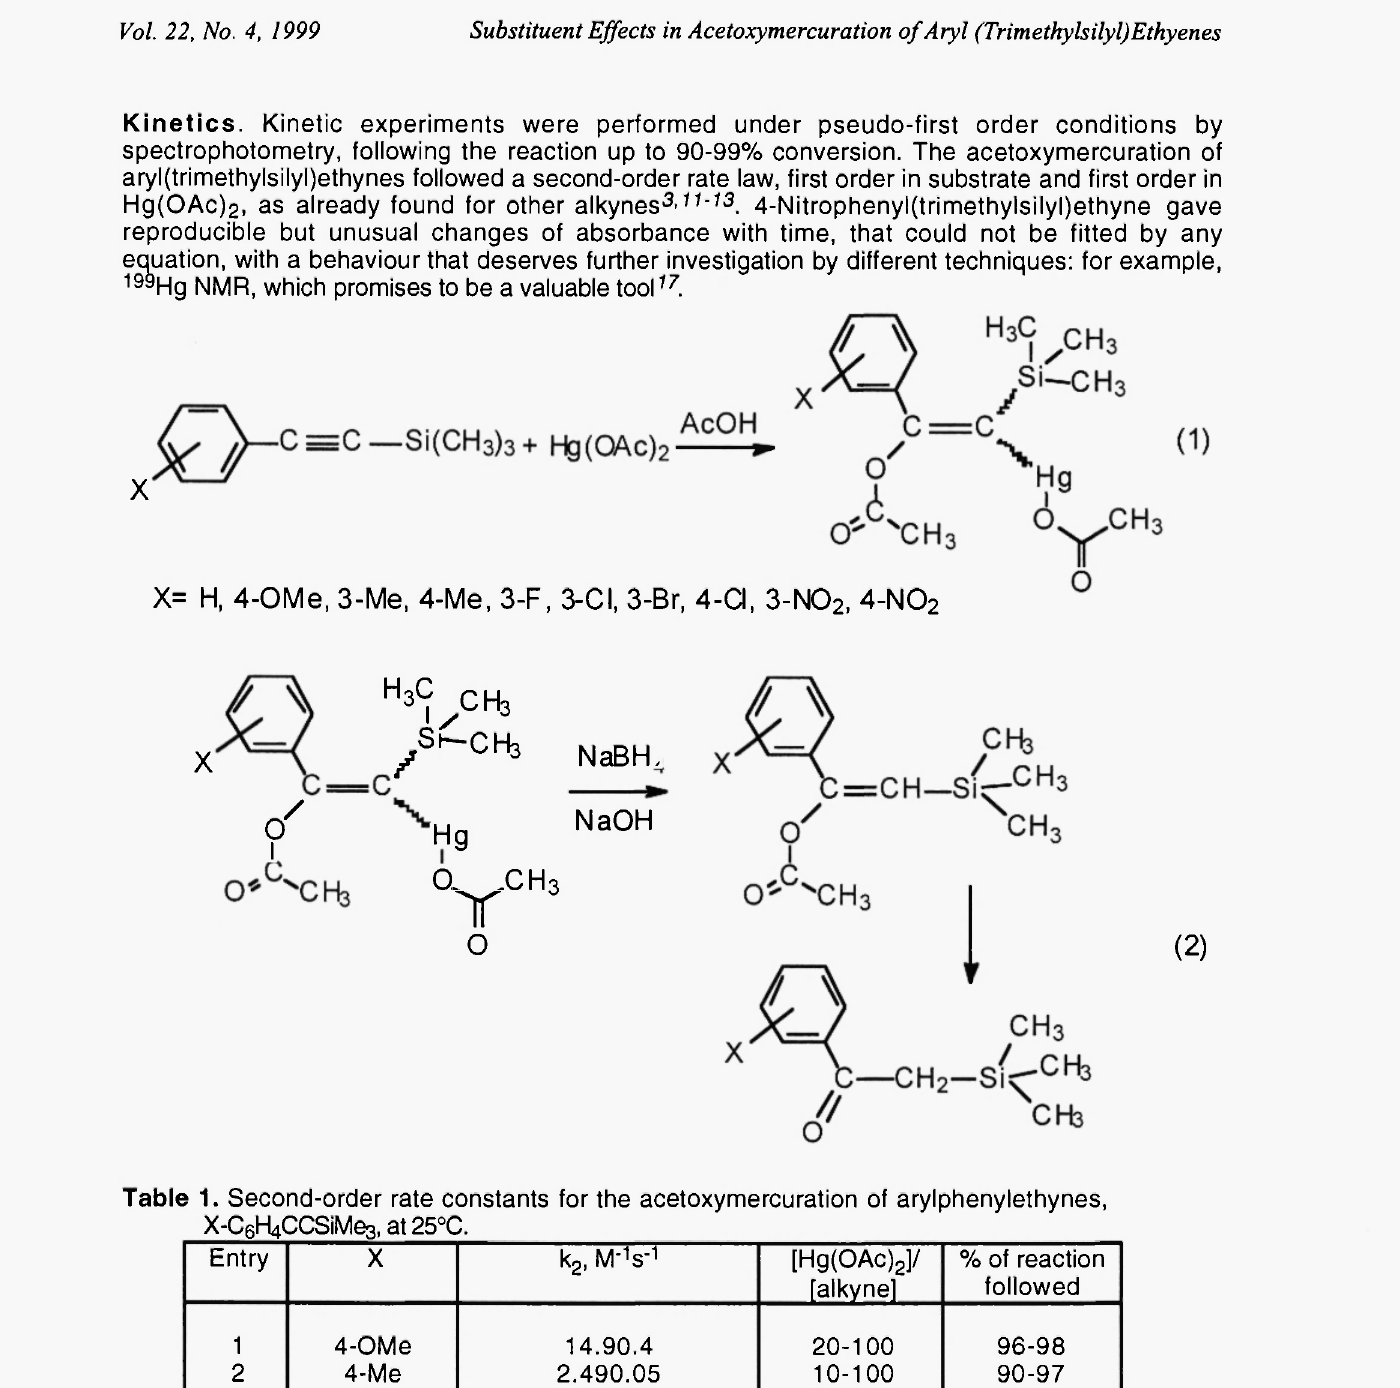
Table 1. Second-order rate constants for the acetoxymercuration of arylphenylethynes, X-C 6